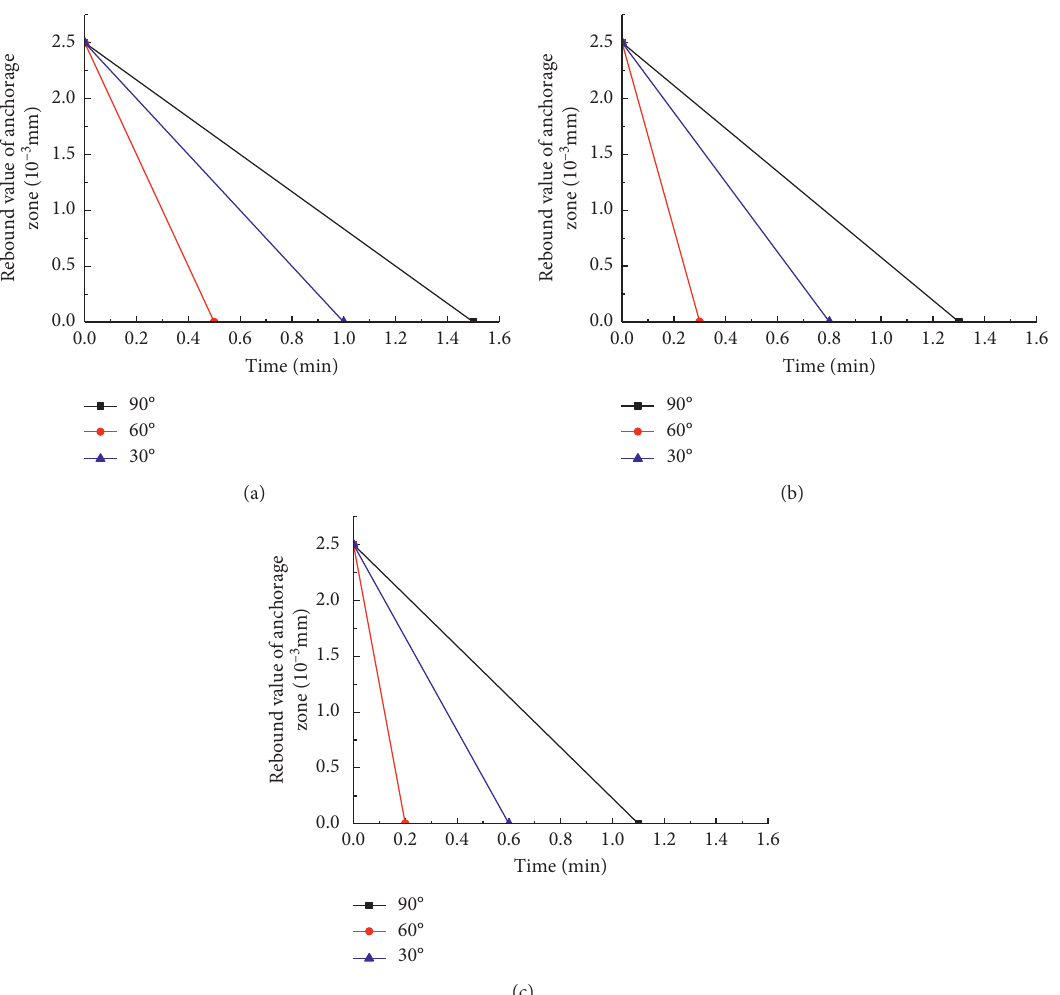
Figure 10: Rebound deformation curve of joint specimen anchorage zone. (a) The stress is 2MPa. (b) The stress is 4MPa. (c) The stress is